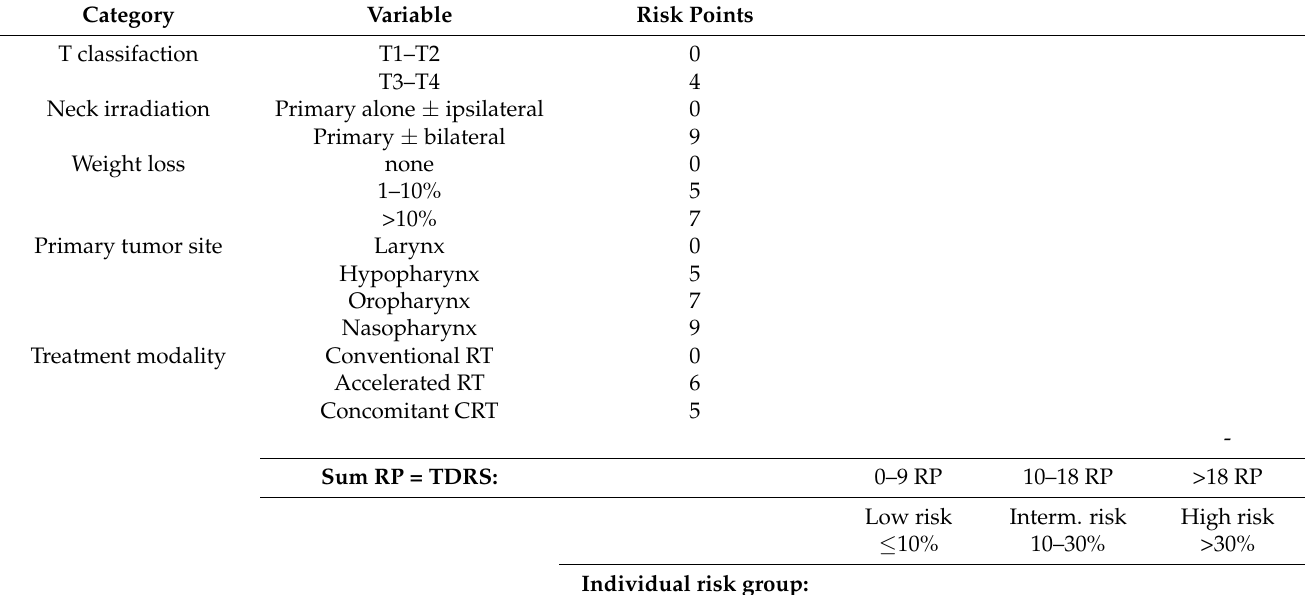
Table 8. Calculation of the Total Dysphagia Risk Score (TDRS): Sum of the respective risk points (RP) per category; subsequently, assignment to the respective risk groups. RP of hypopharynx as primary site extrapolated to 5 from HRs in univariate analysis with larynx set to 1: nasopharynx: HR 7.74 ( ≥ 9 RP) oropharynx: HR 5.16 ( ≥ 7 RP) and thus hypopharynx: HR 3.48 ( ≥ 5 RP); Interm. risk: intermediate risk; modified from Langendijk et. al., 2009